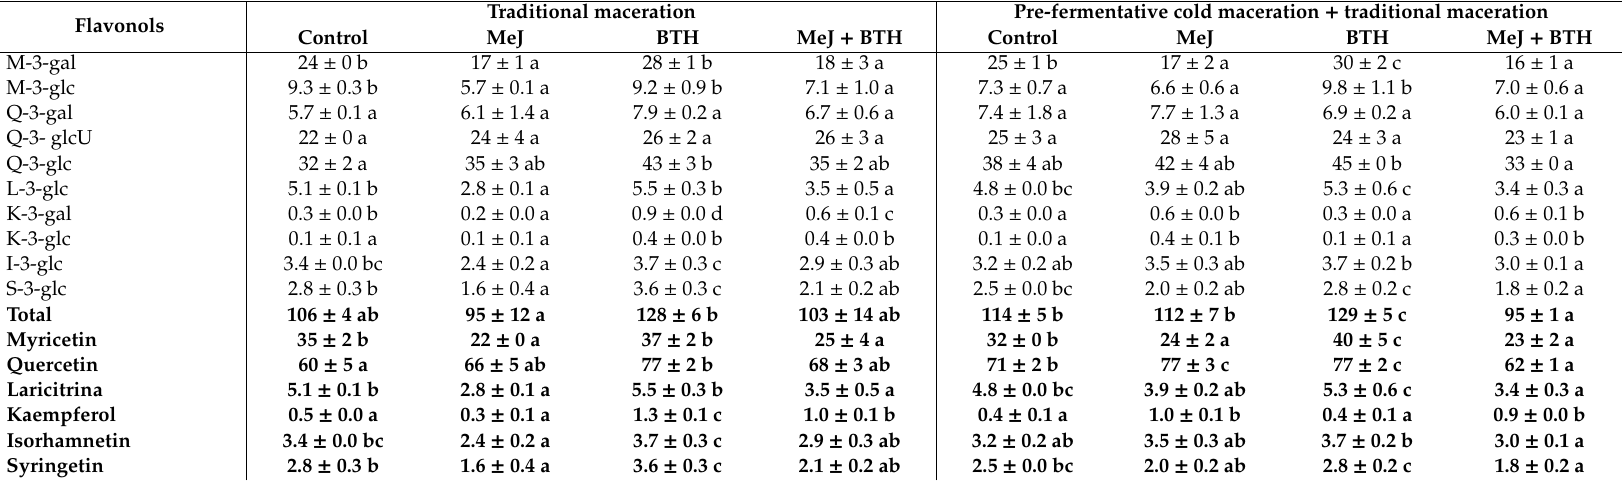
Table 7. Concentration of flavonols expressed as mg / L at the end of alcoholic fermentation in Monastrell wines ( 2017